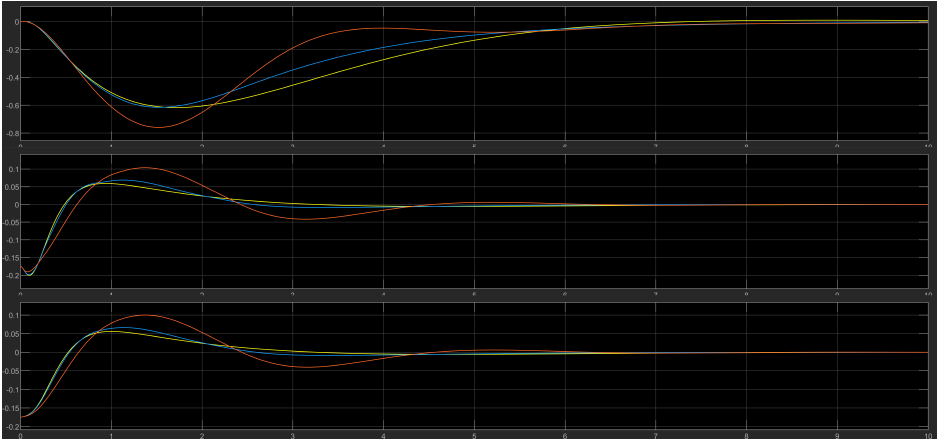
Figure 22. FLC (light blue), LQR (yellow), and modified FLC